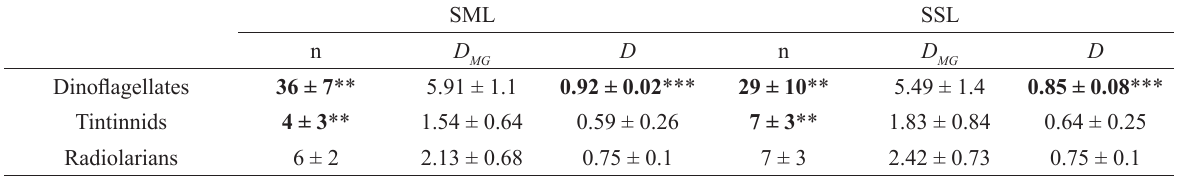
Absolute number of species (n), Margalef species richness ( D ), and Simpson diversity index ( D ) for the assemblages of MG the dinoflagellates, tintinnid ciliates and polycystine radiolarians. Mean values ± standard